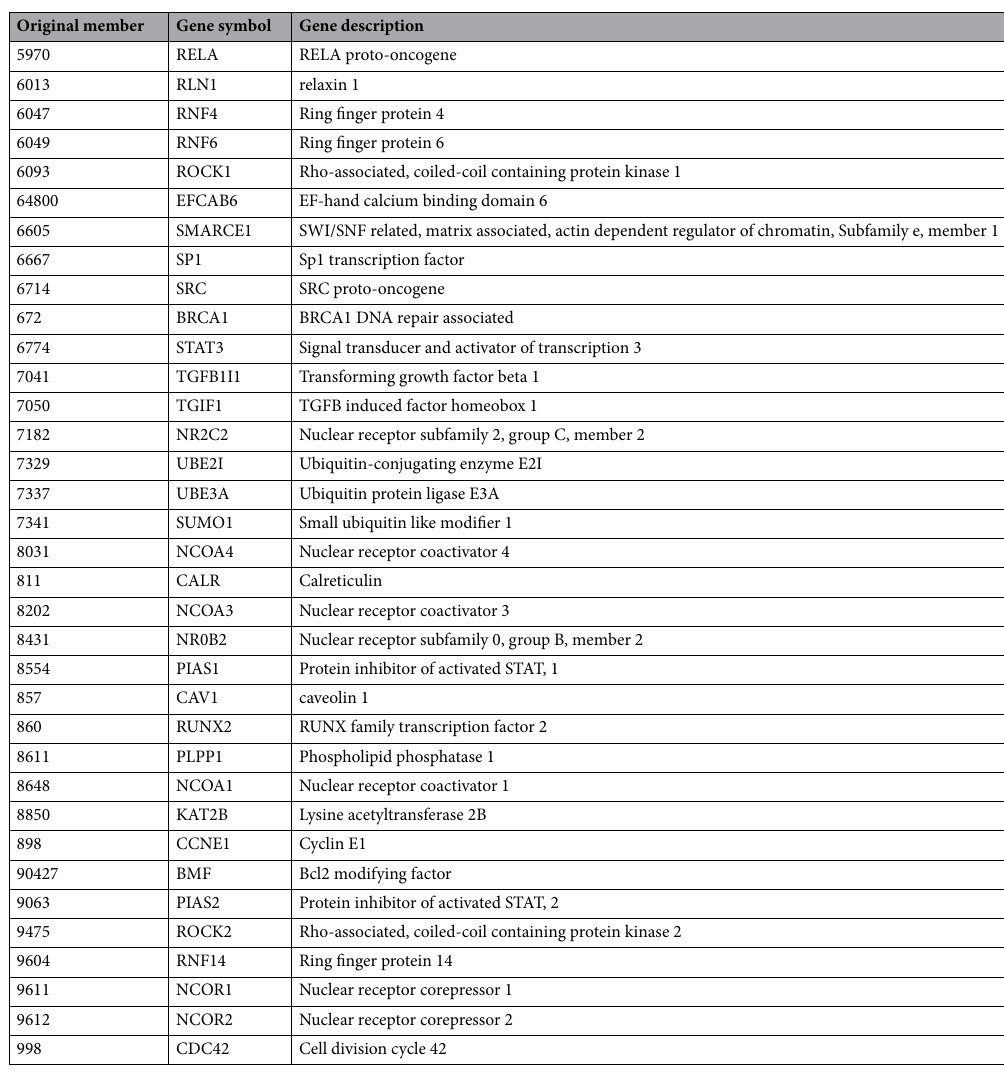
Table 1. Androgen receptor signaling pathway gene